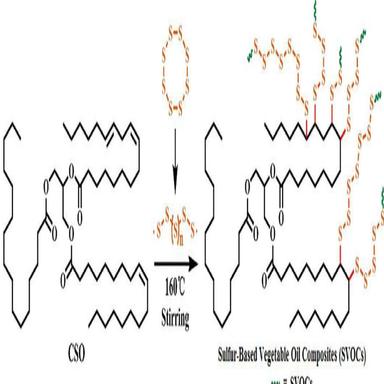
Synthesis route of vegetable oil-based polysulfide.